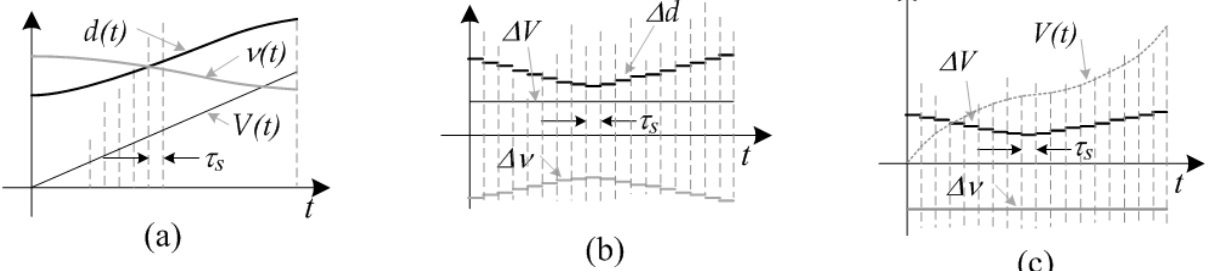
Figure 4. Operating principle of the proposed TLS: ( a ) linearly increasing PZT voltage ( V ( t )) resulting in the non-linear change in the gap ( d ( t )) and the optical frequency ( ν ( t )) of TF, ( b ) the amount of change of each variable during τ s when the PZT-TF voltage increased linearly with time, and ( c ) V ( t ) showing the waveform that made Δ ν constant.